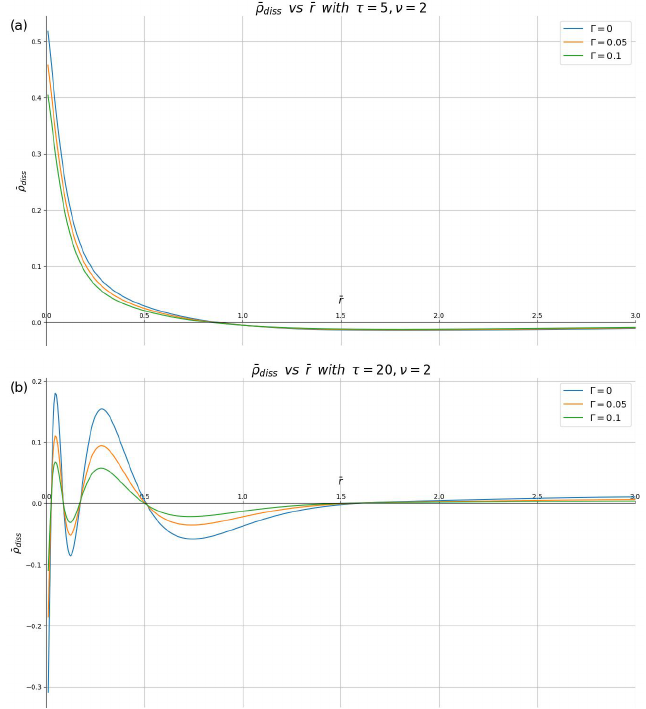
Figure 6. Dissipative part of the induced charge density, ¯ ρ diss , shown in reduced units against the dimensionless radial distance ¯ r for different damping parameters ( Γ = 0,0.05,0.1) with the reduced speed ν = 2, and the reduced times: ( a ) τ = 5 and ( b ) τ = 20.